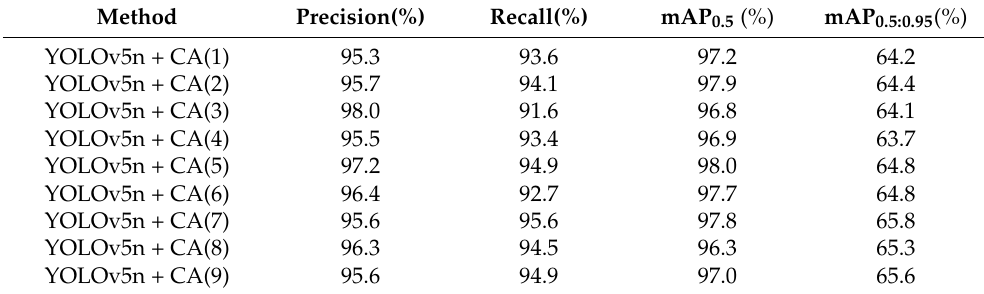
Table 2. Performance scores of models with different fusion configurations on the SSDD dataset.